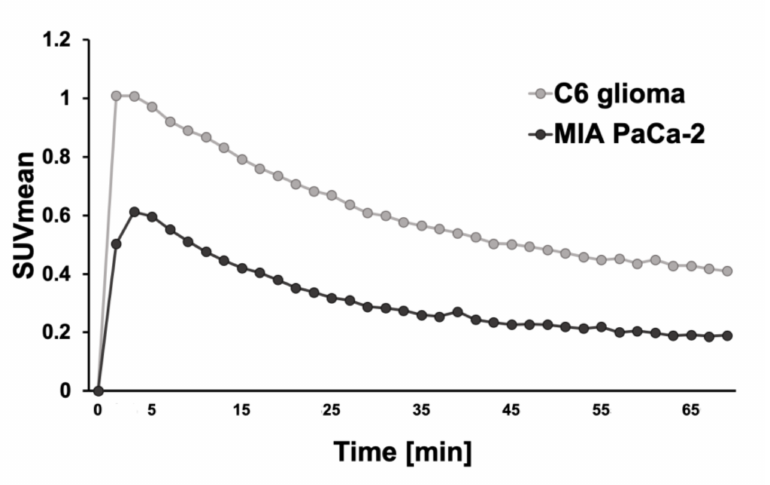
Figure 2. The time-activity curves of the mean standardized uptake value (SUV mean ) of the C6 glioma mouse model ( n = 2) and MIA PaCa-2 ( n =